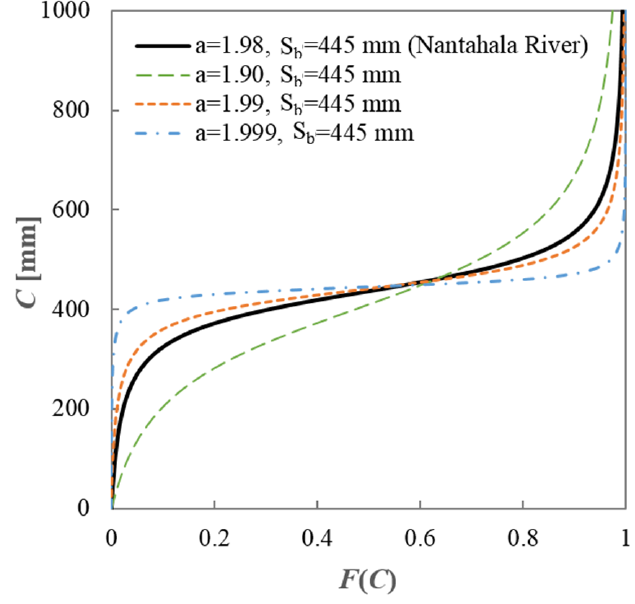
Figure 7. The estimated cumulative distribution of soil water storage capacity in the Nantahala River, North Carolina (USGS gage #03504000), and sensitivities of the shape parameter (a). The catchment is located in a humid area with a climate aridity index of 0.39. The USGS streamflow gage number is 03504000 with a drainage area of 134 km 2 . The estimated shape parameter (a) is 1.98 and the mean of the distribution ( S b ) is 445 mm. Particularly, the shape parameter of most catchments is between 1.90 and 2.0. To show the sensitivity of CDF to the shape parameter, Figure 7 plots the CDF for other 3 shape parameters, i.e., 1.90,